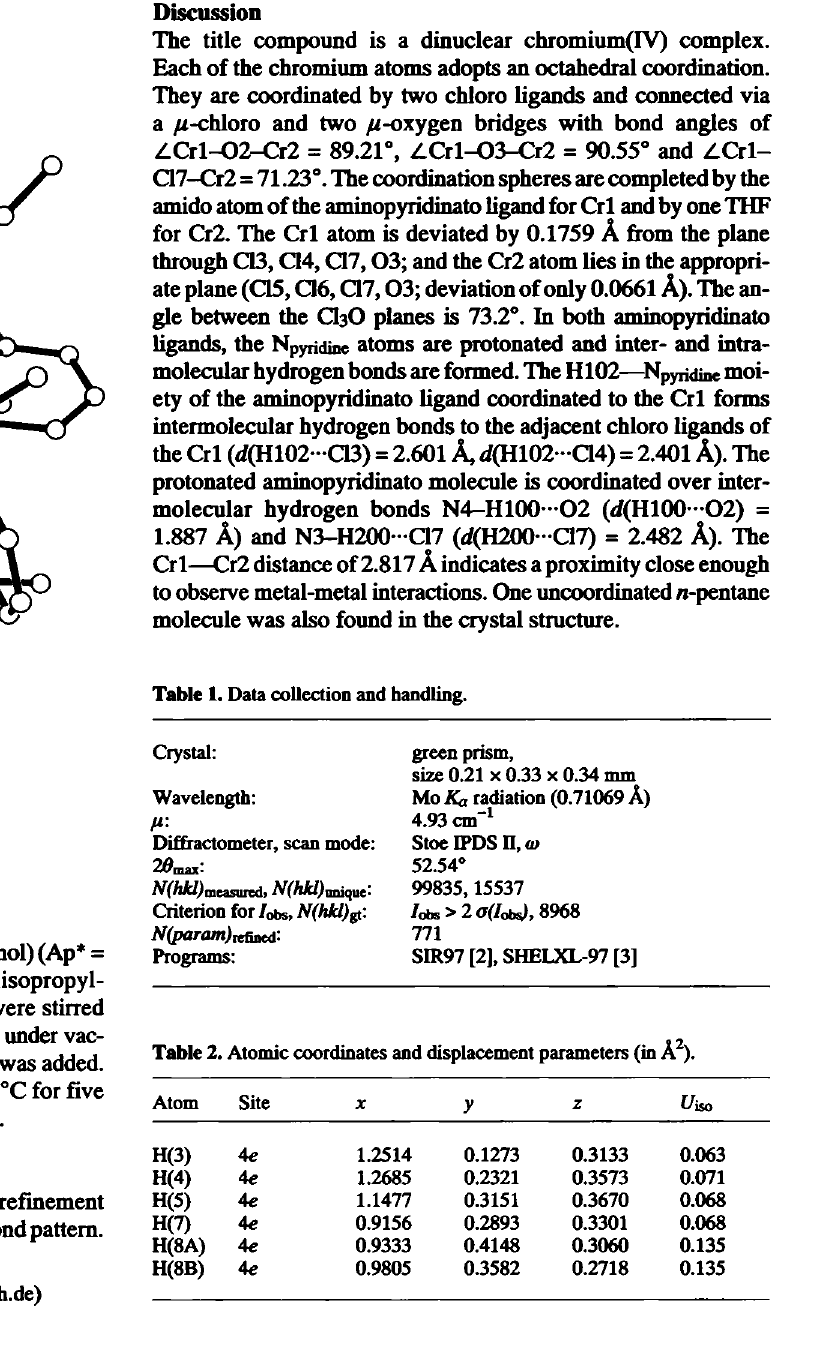
Table 2. Atomic coordinates and displacement parameters (in A 2